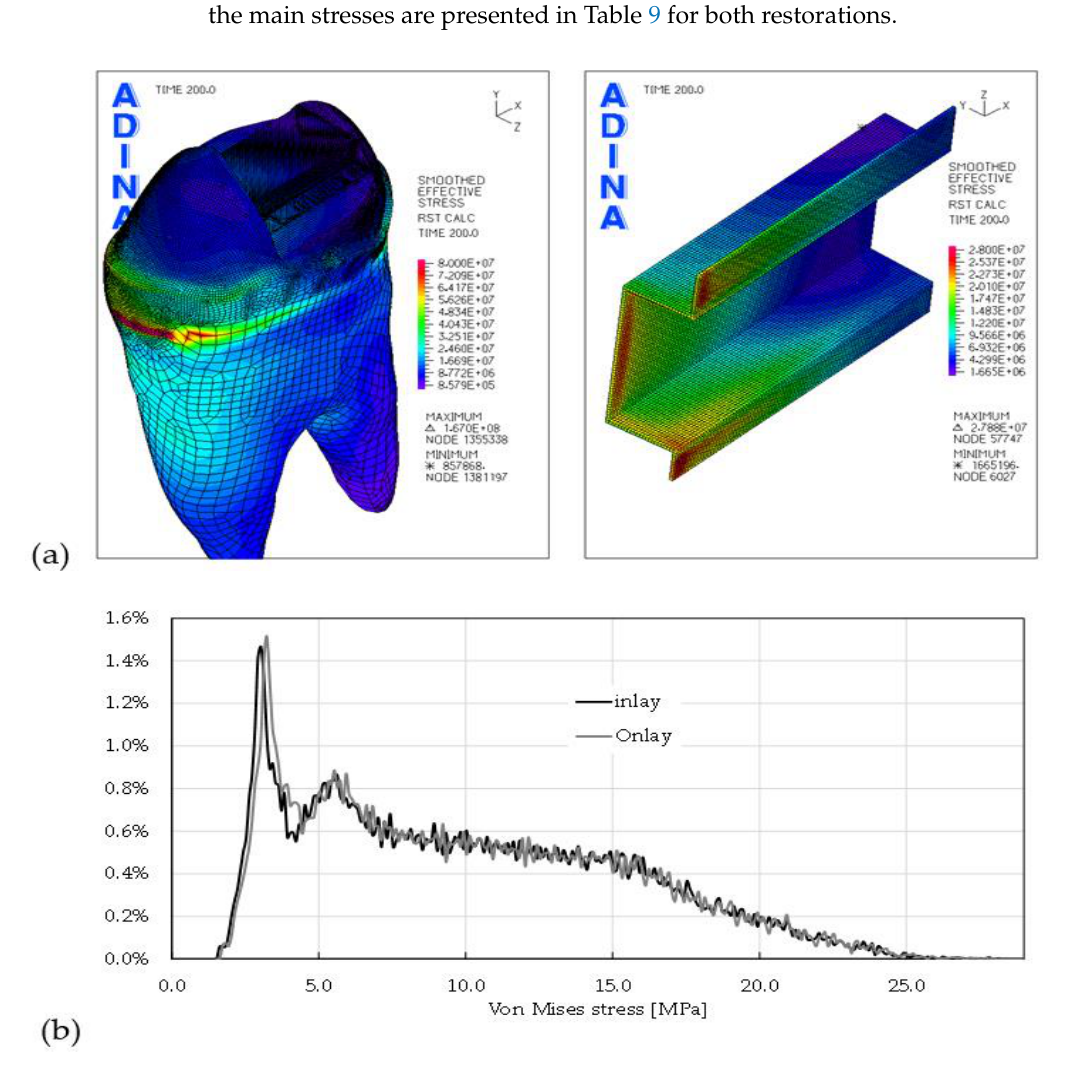
Figure 7. Smoothed stress distributions of the dentin. ( a ) Global perspective view (left side) and the “bed” geometry of the dentin (right side). ( b ) Histograms of the distributions for the “bed” geometry of both